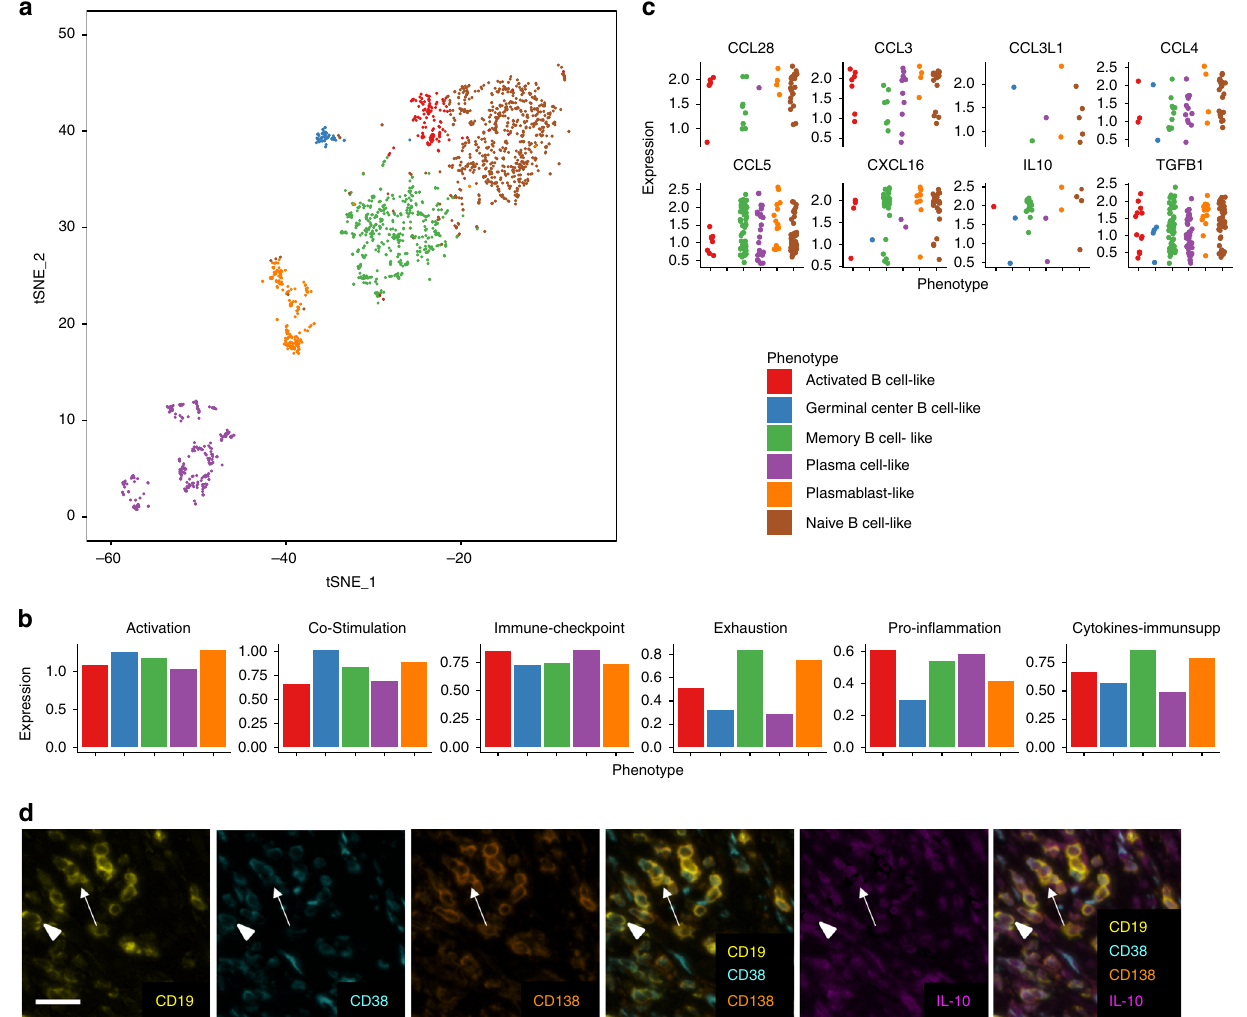
Fig. 3 Human melanoma scRNA-seq data verify observed functional phenotypes. a T -distributed stochastic neighbor embedding representation of all B cells with their respective phenotype annotations from the Sade-Feldman et al. dataset 29 . b ssGSEA estimated expression of the functional signatures based on the average gene expression per B cell phenotype. c Expression of speci fi c chemokines and immunosuppressive cytokines per B cell phenotype and individual cell. d Con fi rmation of IL-10 expression in plasma cell-like (arrow) and plasmablast-like (arrowhead) TAB by quadruple marker immunostaining. Scale bar represents 20 µ